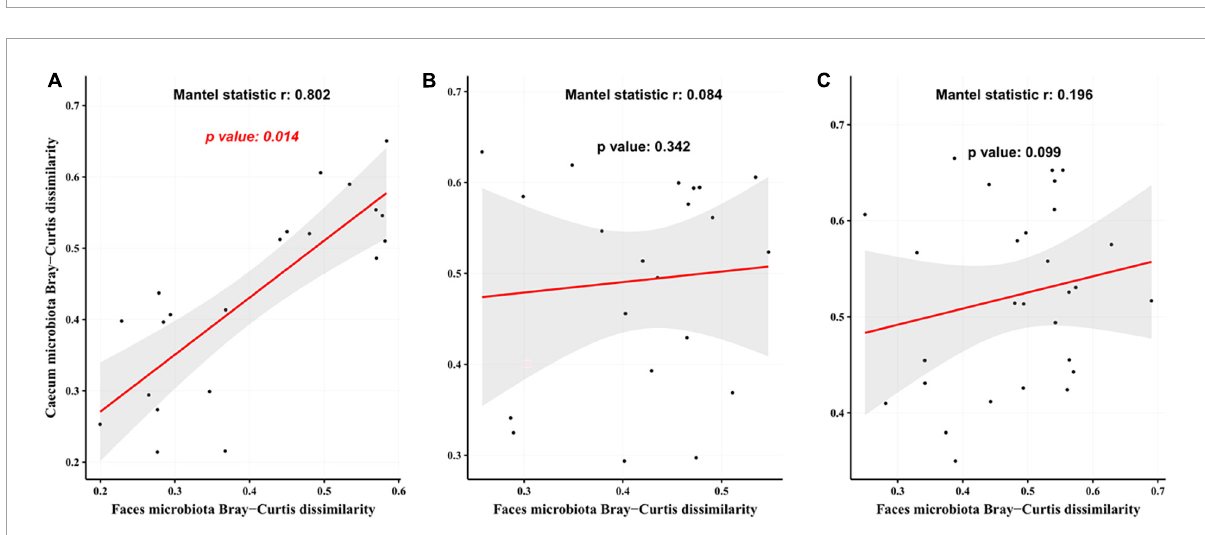
FIGURE7 Correlation analysis of gut microbiota at the end of modeling (week 5) and at the end of the experiment (week 12) based on Bray–Curtis distance matrix. The analysis used the mantel function in vegan package using 999 permutations. (A) The control group (CTL) group; (B) type 2 diabetes mellitus (T2DM) group; (C) Hao9